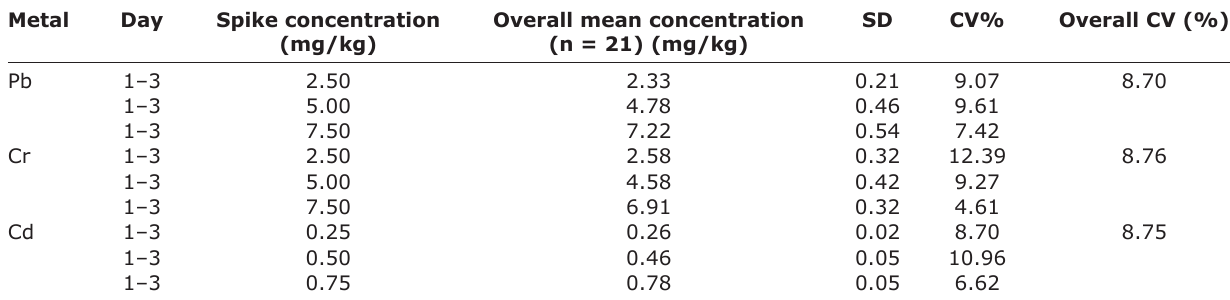
Table-5: The repeatability data of heavy metals in poultry feed. Metal Day